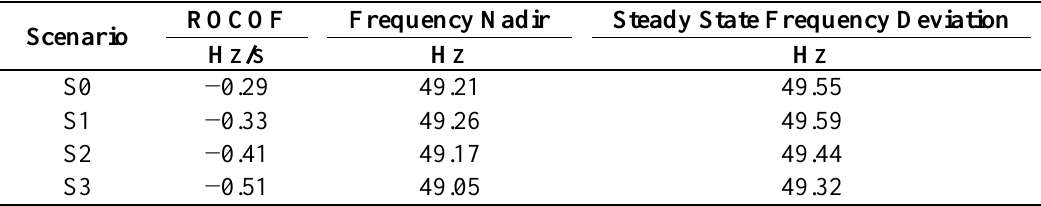
Table 4. Security Indices: PV-PPs with FFR capability, deload margin of